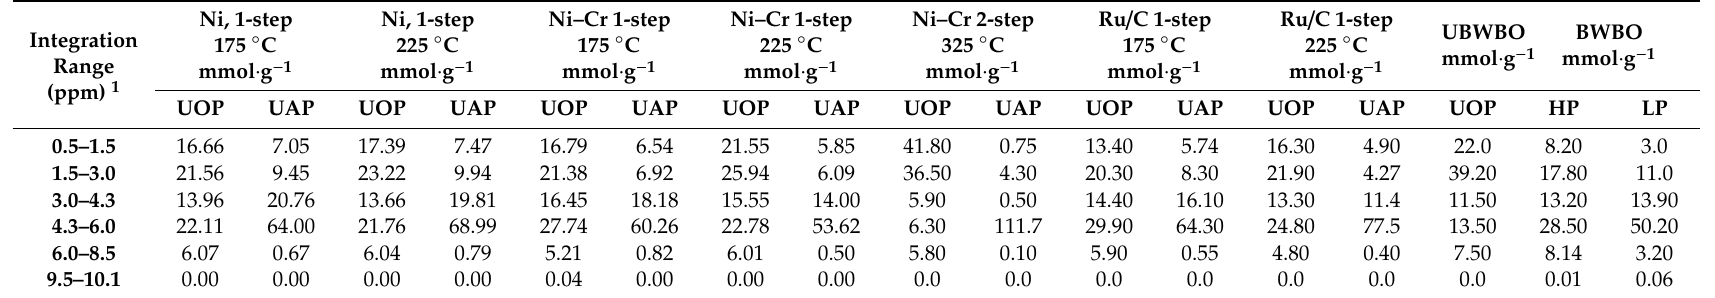
Table 2. 1 H-NMR of upgraded oil and